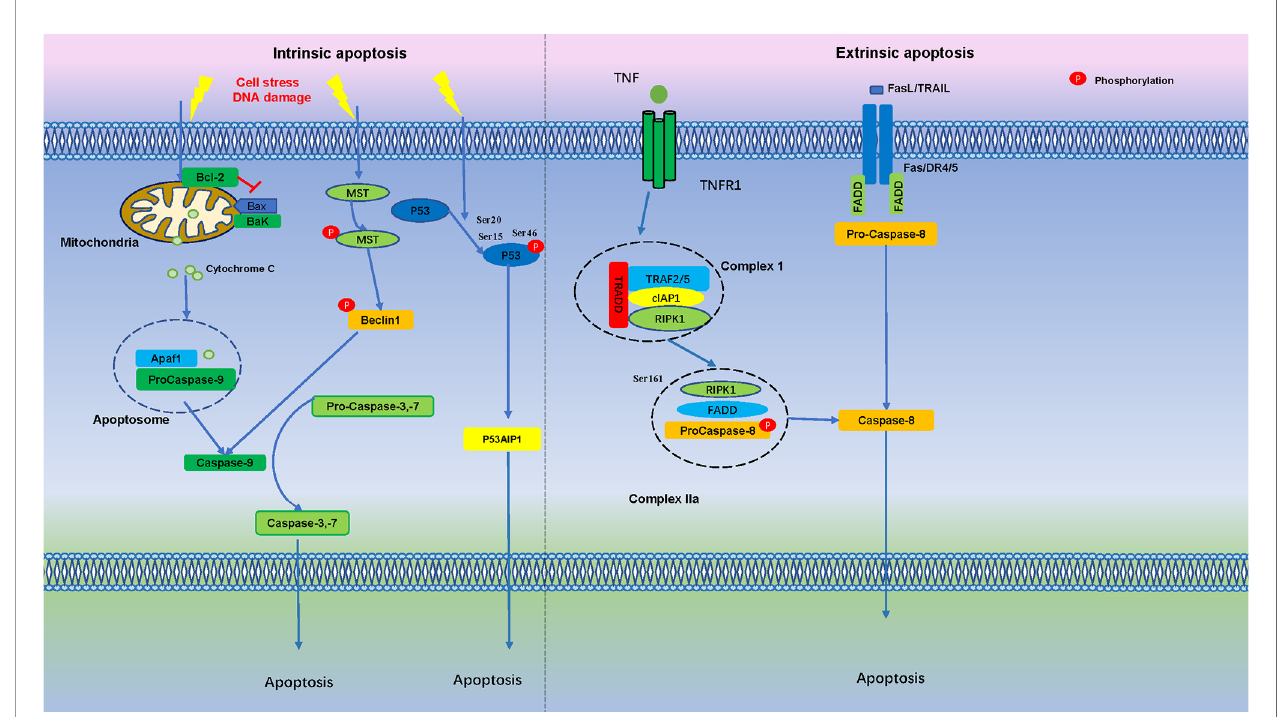
FIGURE 2 | Apoptosis is Regulated by Numerous Phosphorylation Events. In the intrinsic apoptosis pathway, cell stress and DNA damage promotes mitochondria release cytochrome C into the cytoplasm, binds with Apaf1 and pro-caspase-9 to form an apoptosome. Apoptotic stimuli lead to MST autophosphorylation and triggers Beclin1 phosphorylation, which activate caspases. After initial DNA damage, p53 is phosphorylated at Ser15 and Ser20, if DNA damage is severe, phosphorylation of p53 protein at Ser-46 forms TP53INP1 and induce cell apoptosis. In the extrinsic apoptosis pathway, Fas/FasL, death receptor 4 (DR4), death receptor 5 (DR5) and TNFR1 bind to their ligands to induce pro-caspase-8 activation, which then cleaves and activates effector caspases, such as caspase-3 and caspase-7, further activation of downstream effector molecules then leads to